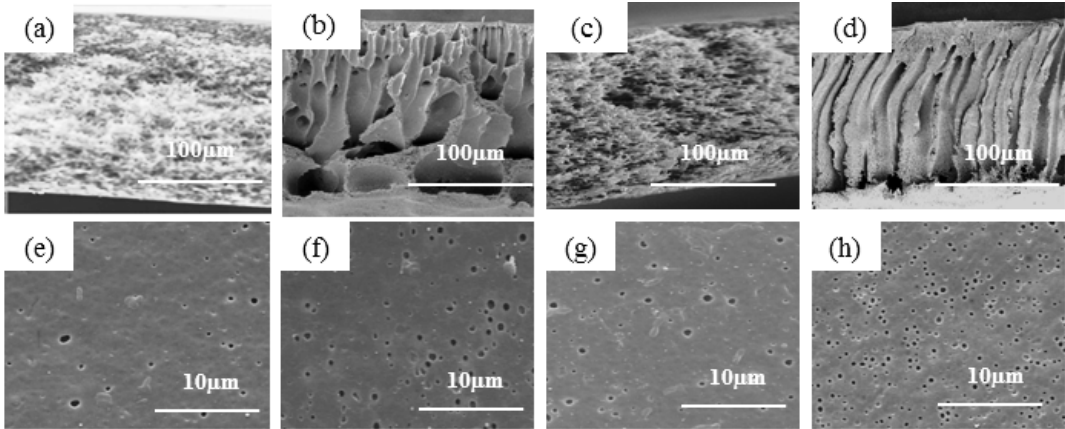
Fig. 1. FE-SEM cross-section (a–d) and top surface (e–h) images of M1 (a, e), M2 (b, f), M3 (c, g) and M4 (d, h) membranes. Table 2. Porosity, mean pore size, surface porosity and PWF of Table 2. Porosity, mean pore size, surface porosity and PWF of membranes. Membrane